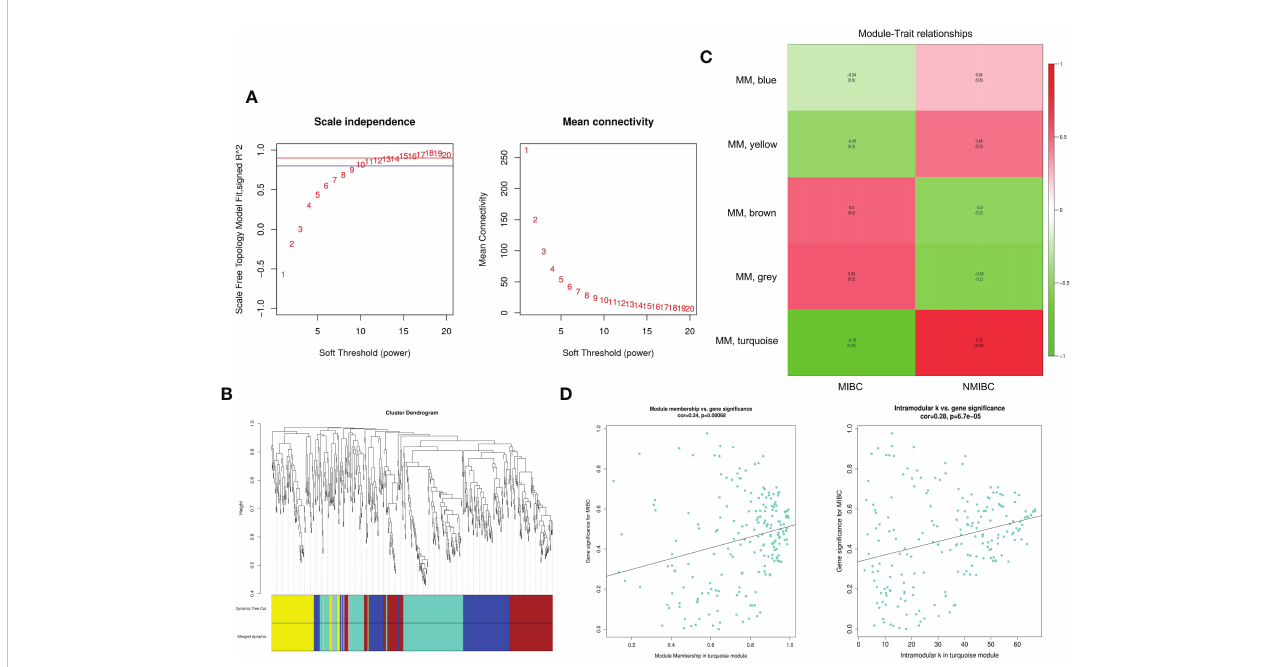
FIGURE 4 The exploration for module relevant to invasion depth of bladder cancer by WGCNA. (A) The appropriate power value was selected according to the scale-free network principle. We consider the minimum power value (p = 10) as the parameter for subsequent analysis when the correlation coef fi cient (scale-free fi t index R 2 (R 2 = 0.80)) reaches the platform stage. (B) Dynamic Tree Cut is a dendrogram of the DEGs divided according to the clustering results. (C) The heatmap reveals the correlation between different gene modules and clinical features (MIBC and NMIBC). (D) Pearson ’ s correlation analysis between GS, MM, and K.n values of turquoise module and MIBC. WGCNA, weighted gene co-expression network analysis; DEGs, differentially expressed genes; MIBC, muscle-invasive bladder cancer; NMIBC, non-muscle-invasive bladder